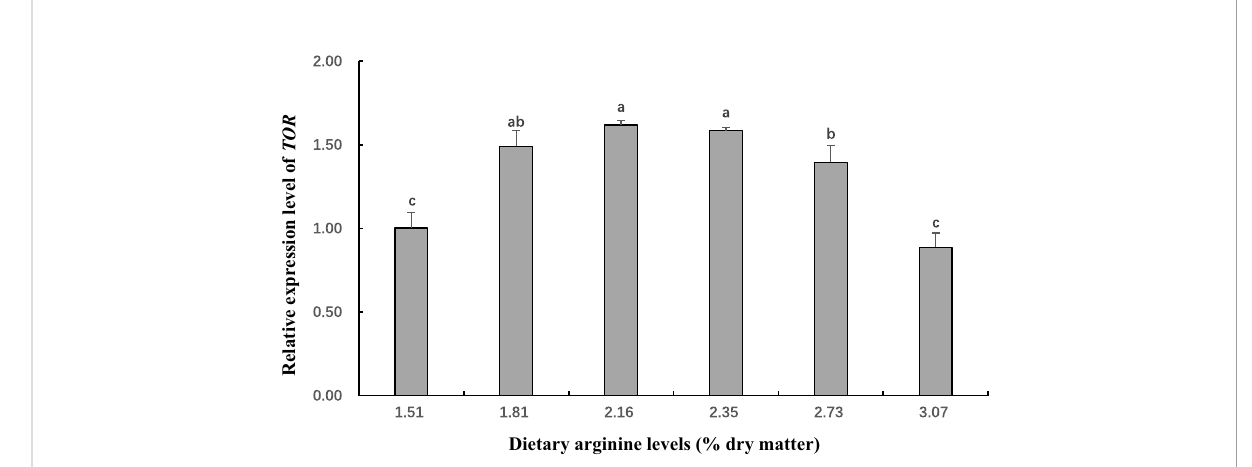
FIGURE 4 The gene expression (Rapamycinin ( TOR ) in muscle) of postlarval Scylla paramamosain fed diet with different arginine levels. Means in the same row with different superscripts are signi fi cantly different (P< 0.05).